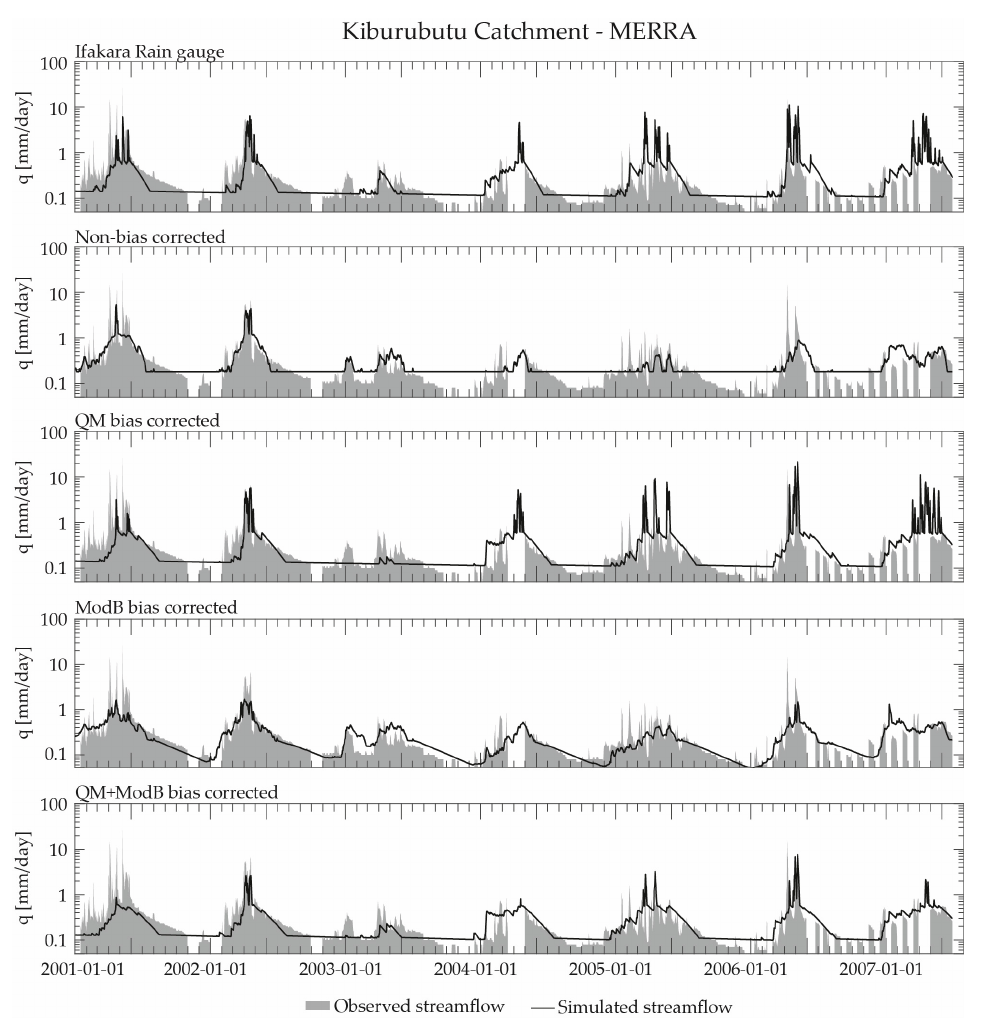
Figure 4. Semilog plots showing KC hydrographs of simulated (black line) and observed (grey filled area) specific discharge. Panels show observed and simulated discharge from calibrations using rain gauge data ( top ); the non-bias corrected data ( second ); quantile mapped (QM) bias corrected data ( third ); model based bias correction (ModB) bias corrected data ( fourth ) and combined QM + ModB bias corrected data ( bottom ).